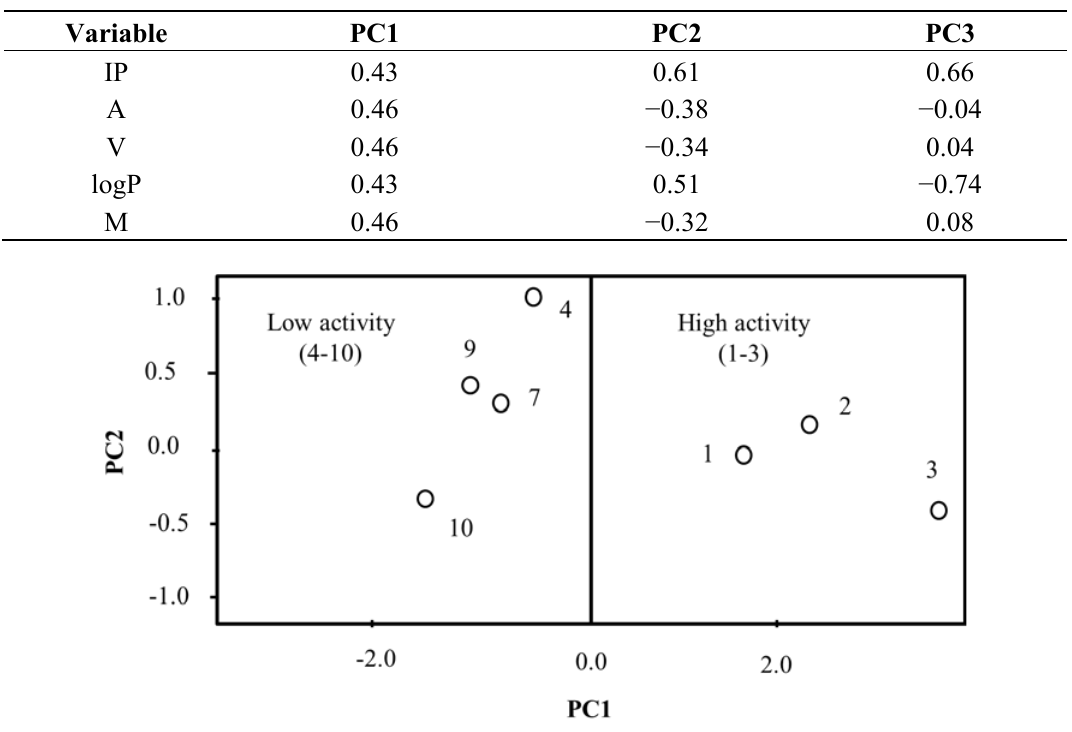
Figure 4. Plot of the score vectors of first principal components for cytotoxicity of compounds from C. zedoaria against MCF-7